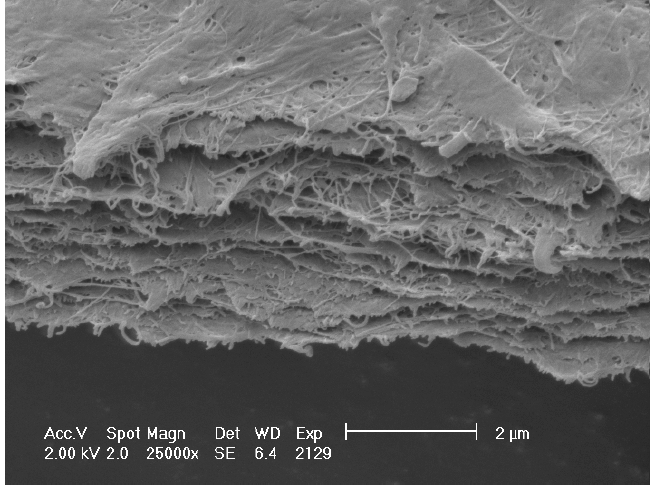
Figure 4. SEM micrograph of bacterial cellulose/pectin composite.